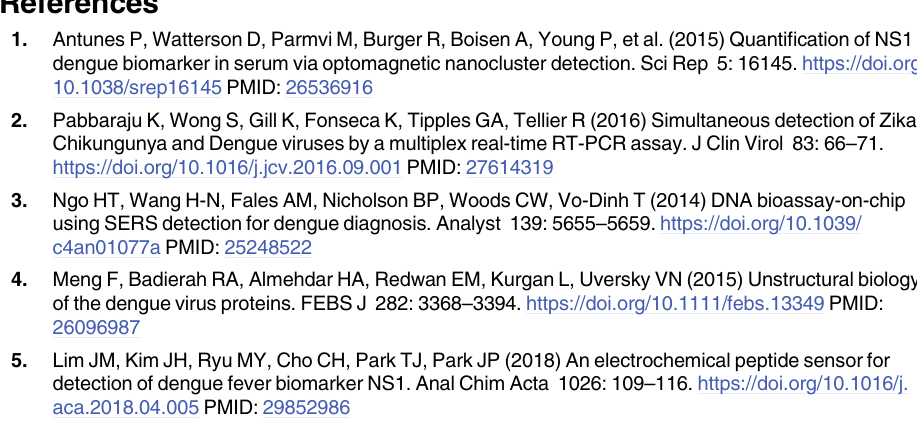
S1 Table. Characteristics of the synthetic peptides used in this study. S1 File. Comprises: Electrochemical response using non-functionalized gold electrode (Fig A); Selectivity test of DGV BP1 peptide (Fig B); Calculation of limit of detection (Fig C); Repeatability test (Fig